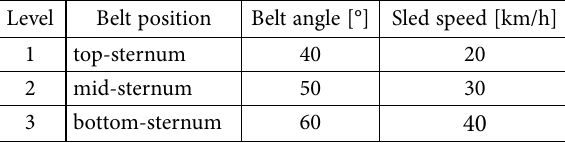
Table 2. Definition of the levels of three factors